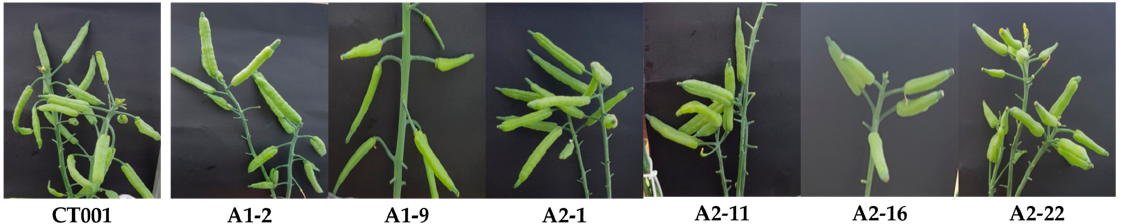
Figure 4. Pod formation following bud pollination in ‘CT001 ′ inbred line and E 0 AGAMOUS-like (AGL) -edited lines. No difference in pod shape and seed formation was observed between inbred and E 0 AGL -edited lines.